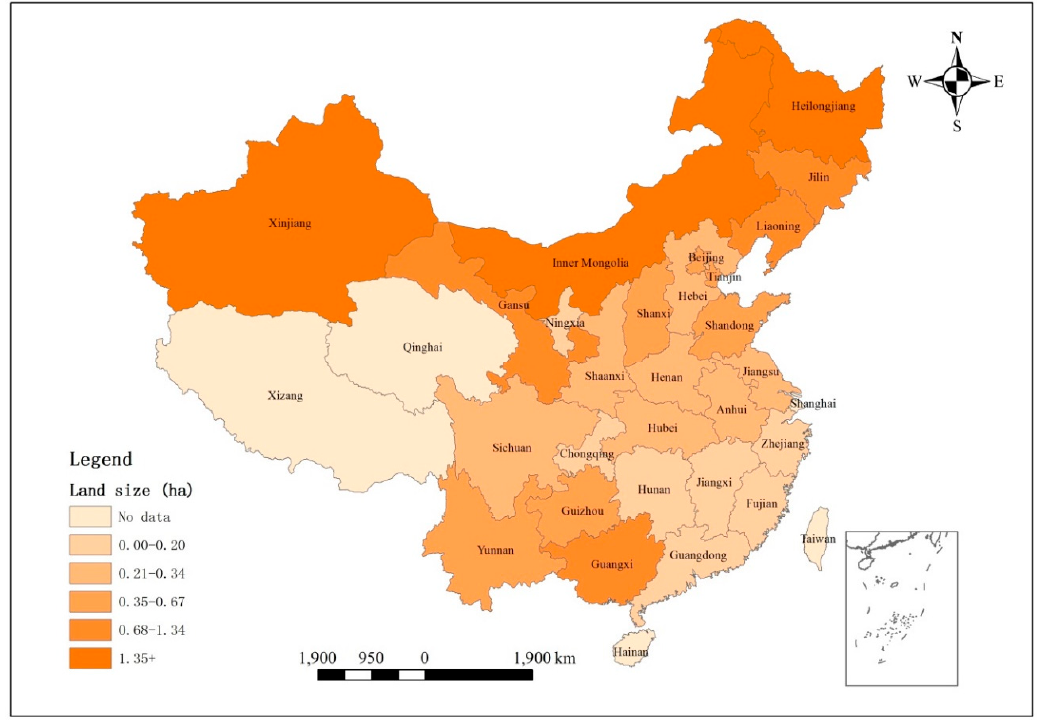
Figure 2. Spatial distribution of the land management scale of rural households.